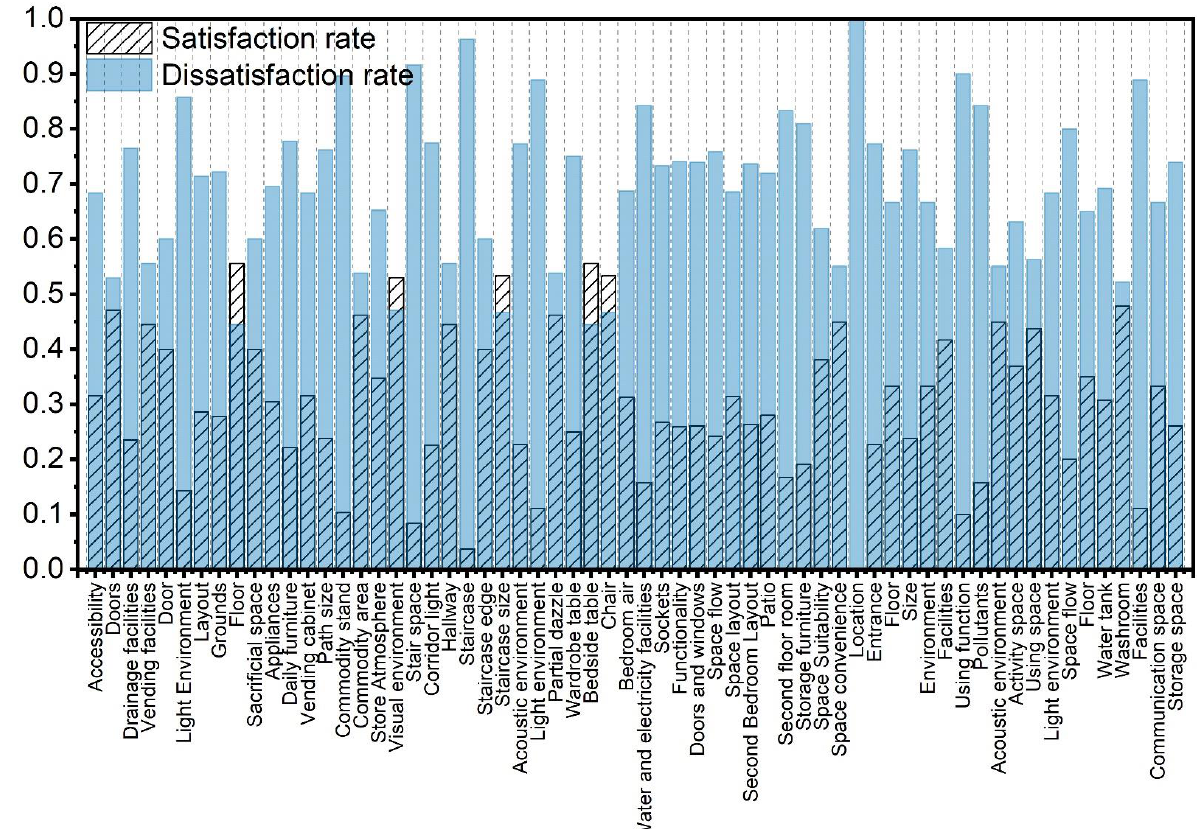
Figure 9. In-depth interviews of the elderly regarding the residential environment.